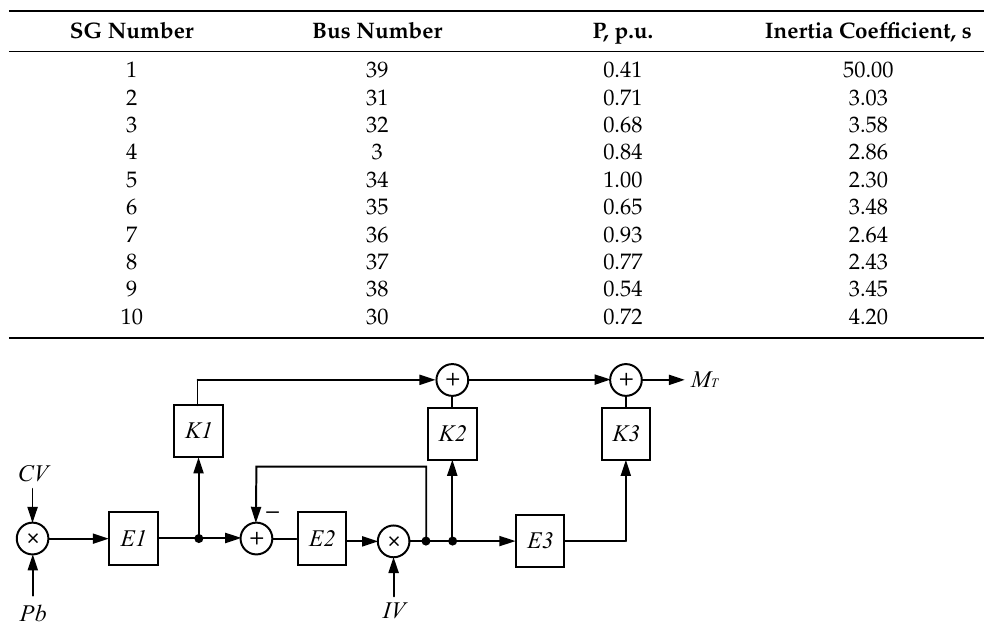
Table 1. Initial states of generators.